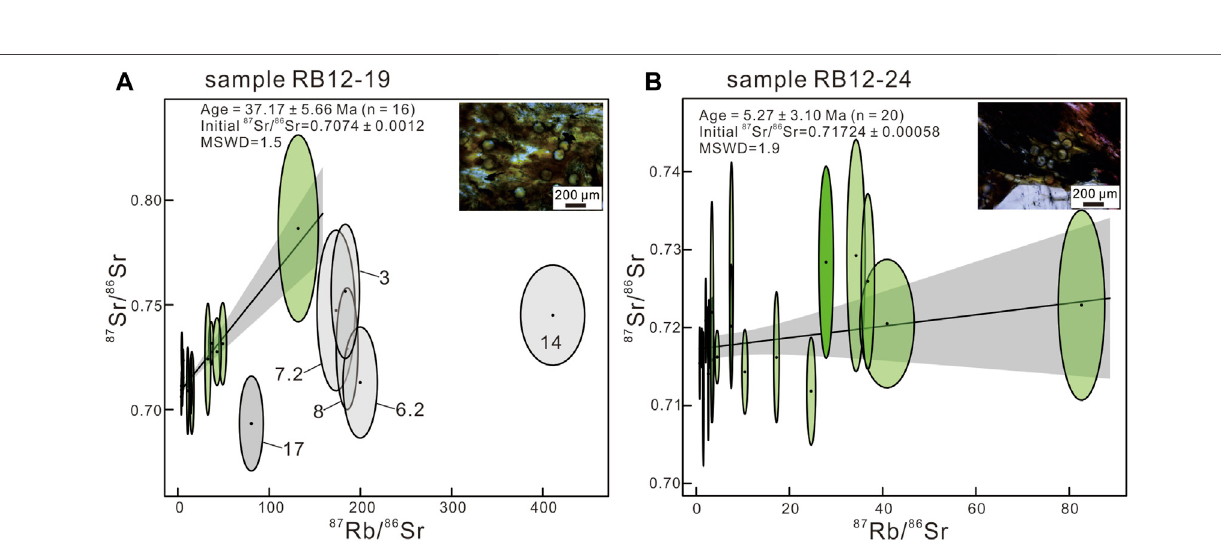
( Figure 9B ). Obviously, this age is younger than that of sample RB12-19, although samples RB12-19 and RB12-24 were collected at the same outcrop, which may be due to